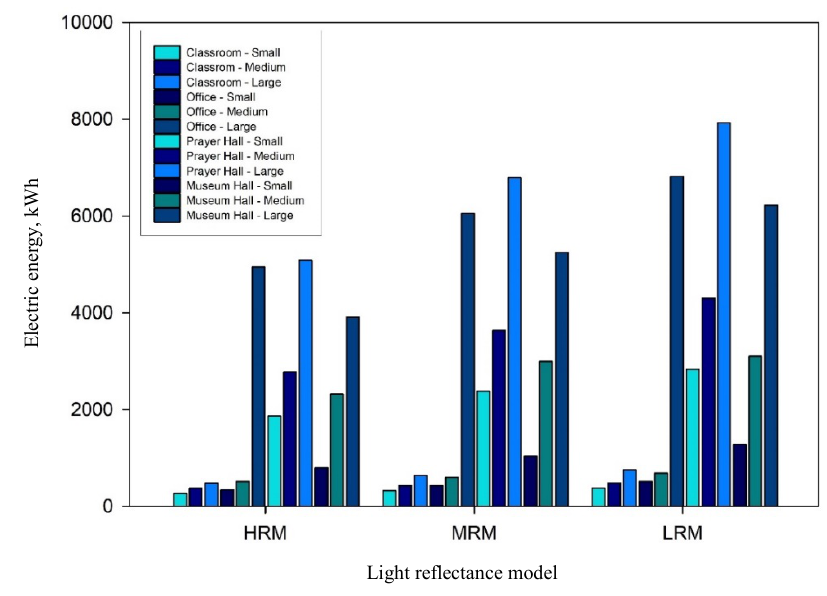
Fig. 3. Electric energy consumed by lighting [kWh] in classified occupied spaces for simulated High Reflectance Model, Medium Reflectance Model, Low Reflectance Model.